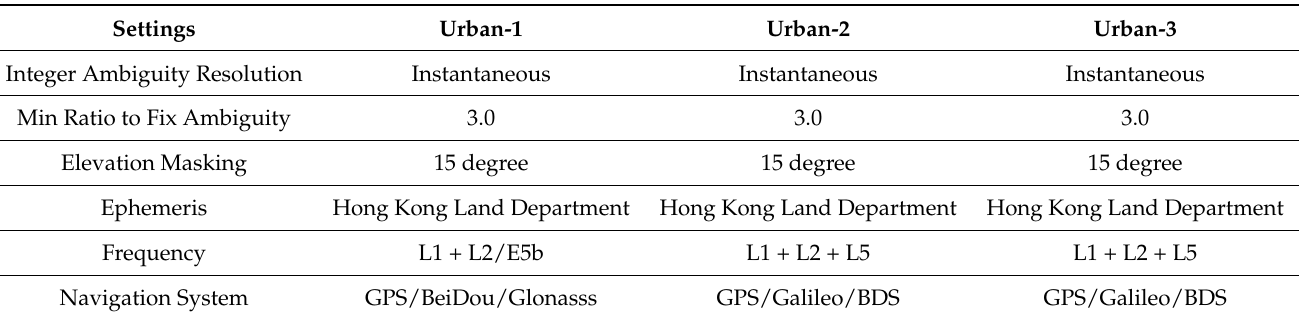
Figure 5. ( a – c ) The ground truth of urban-1, urban-2, and urban-3 is shown by Google Earth from the bird-eye view respectively. Table 2. The settings specified in the RTKLIB when processing the raw GNSS measurements from u-blox to achieve GNSS-RTK